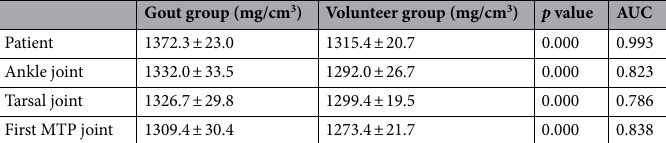
Table 1. Comparison of MLLSV between gout group and volunteer group.